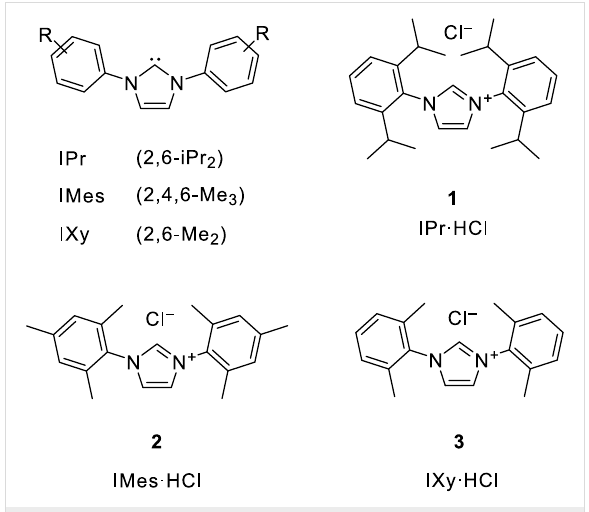
Figure 1: The carbenes IPr, IMes, IXy and their imidazolium salt